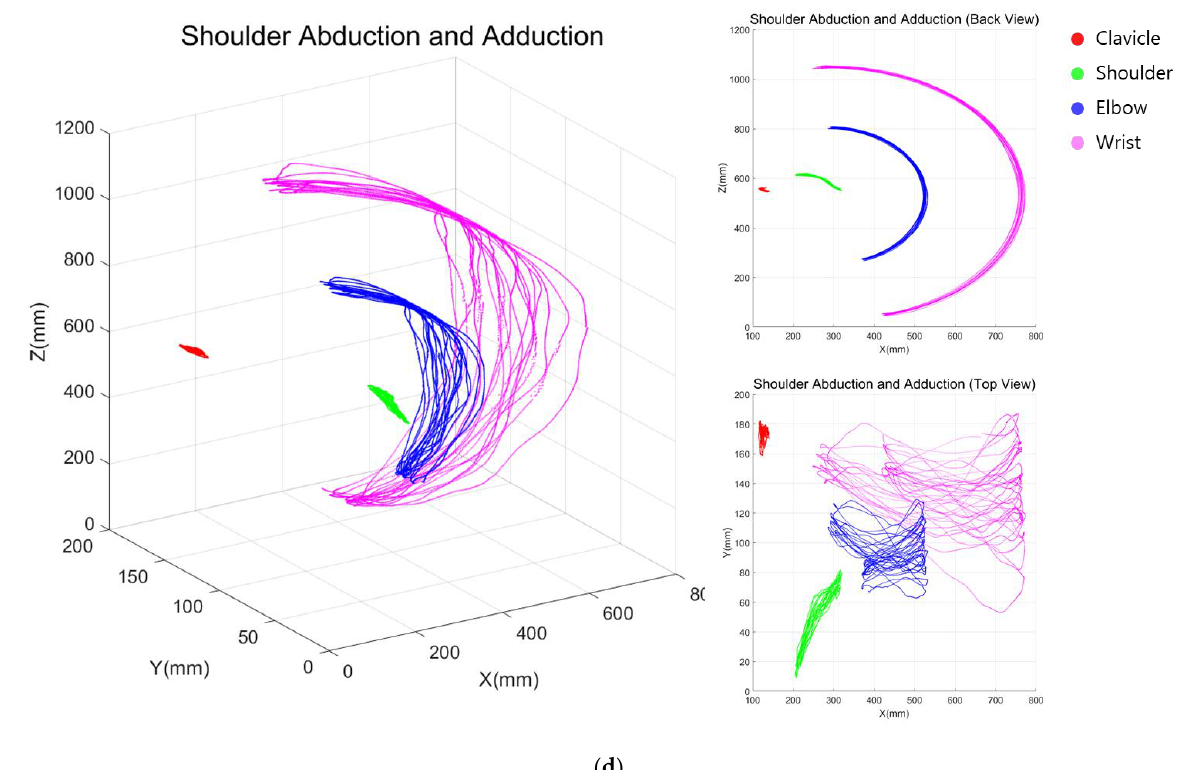
Figure 8. Joint rotation angle with ROM and simulation by analysis of the inverse kinematics. ( a ) Realized rotation degree variation. ( b ) Average ROM of males and females in abduction and adduction. ( c ) Simulation results of abduction and adduction. ( d ) Joint-centered trajectory graph in a 6-axis arm structure.